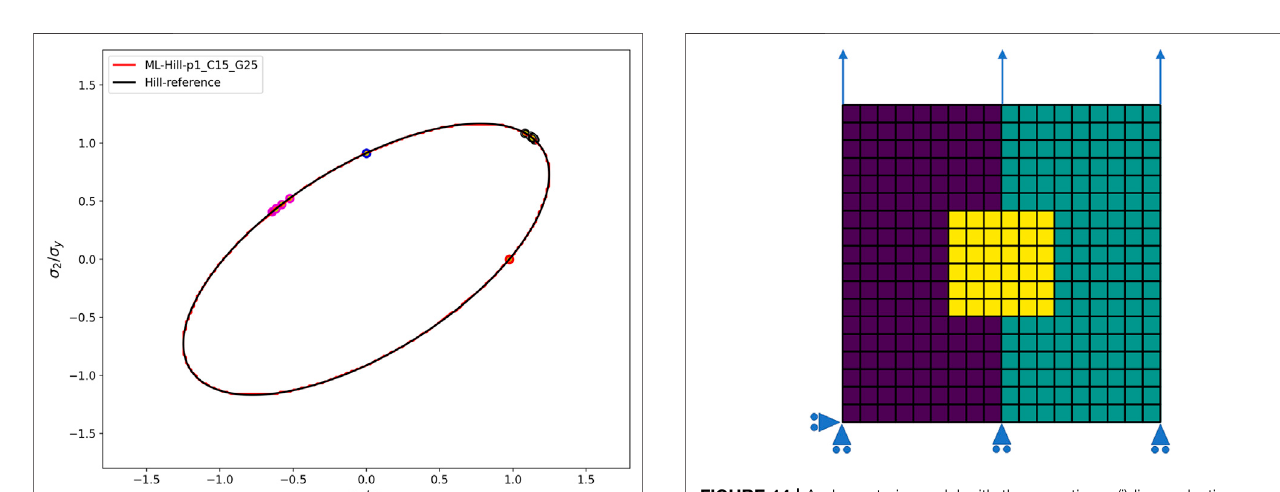
FIGURE 14 | A plane strain model with three sections: (i) linear elastic (yellow), (ii) elastic, ideal-plastic reference material with analytic Hill-type yield function (purple), and (iii) elastic, ideal-plastic material with ML yield function (green).Theelementsformingaregularmeshareindicatedaswellasthe imposed displacements at the